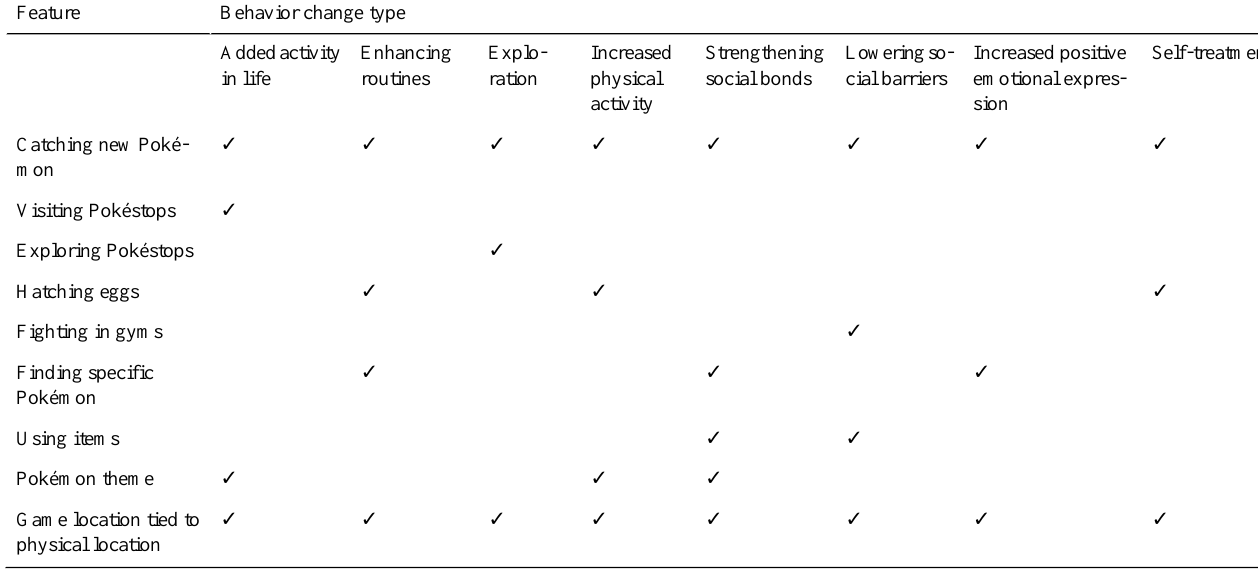
Table 2. Features of Pokémon GO and their related behavior change types.